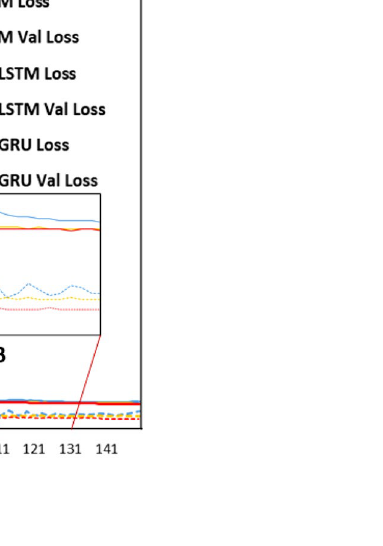
Figure 18. Comparison of model loss